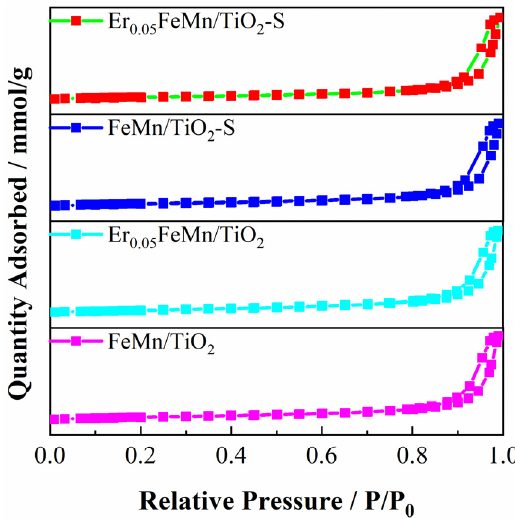
Figure 2. N 2 adsorption/desorption isotherms of the fresh and used FeMn/TiO 2 and Er 0.05 FeMn/TiO 2